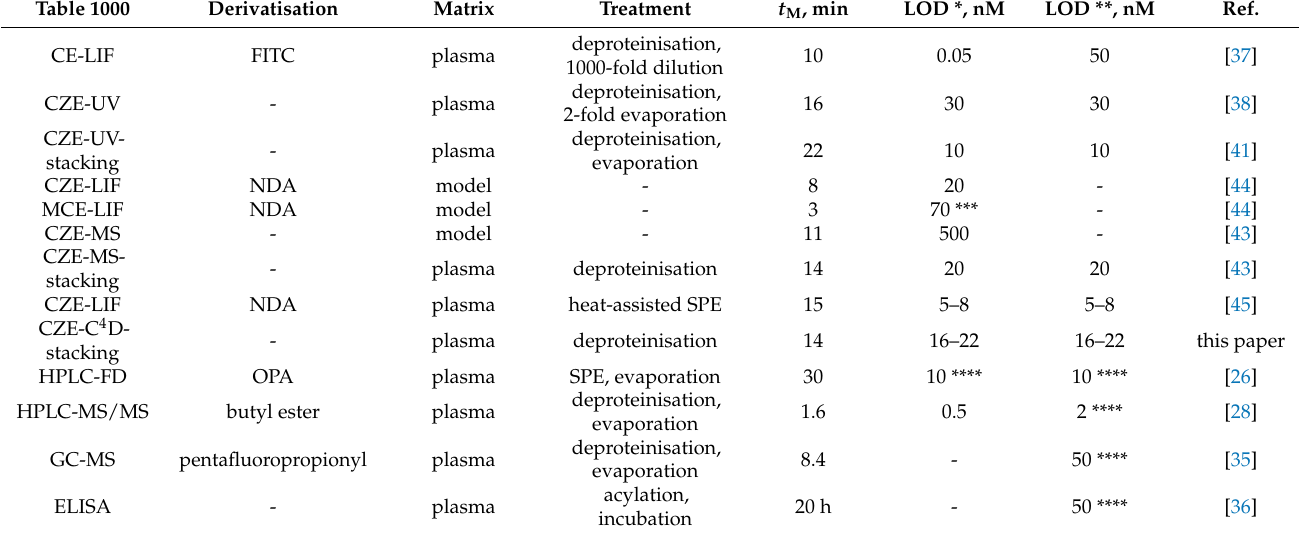
Table 2. Parameters of the electrophoretic and chromatographic determination of ADMA in the model samples and blood plasma, t M migration or retention